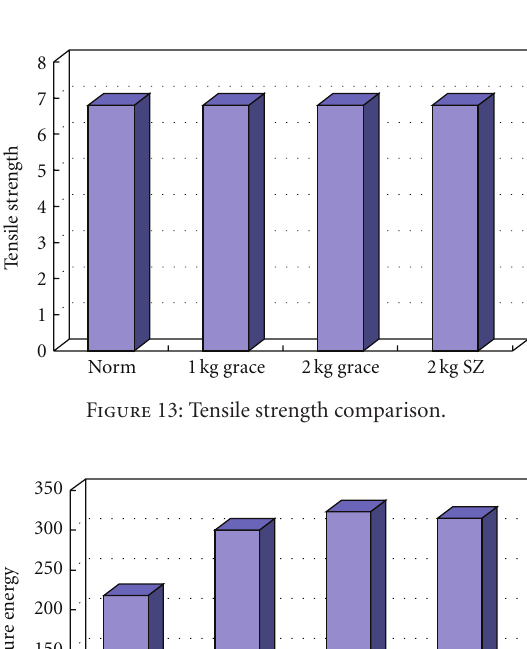
Figure 12: Cracking strength comparison.